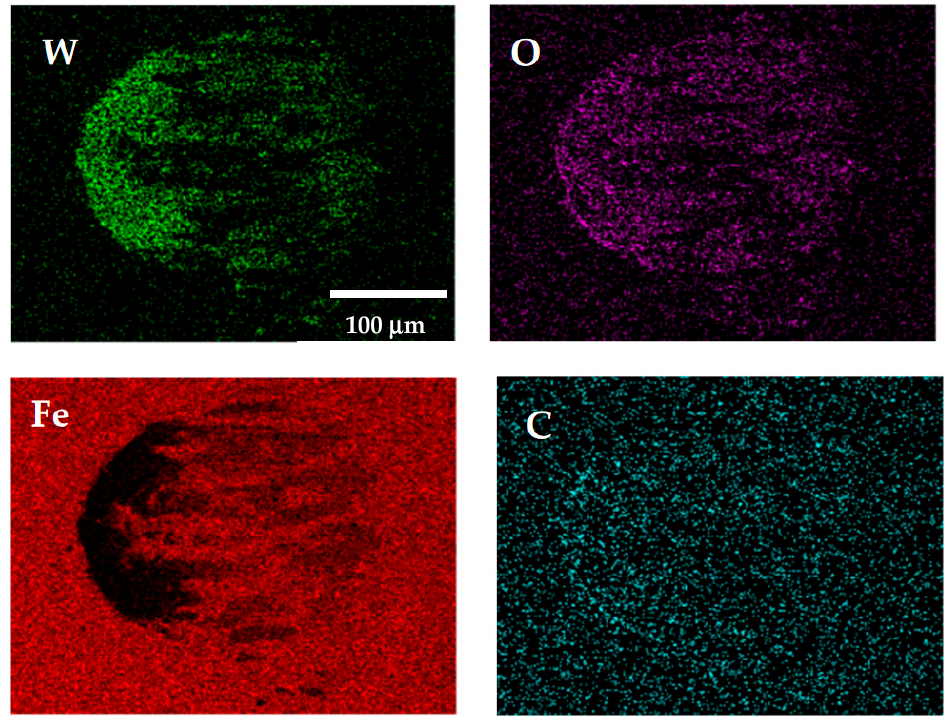
Figure 13. EDS maps of the distributions of W, O, C and Fe, respectively, in the wear scar (see Figure 12d) for the coating W-C:H (1C 2 H 2 -0H 2 ) after friction test to 6800 m.